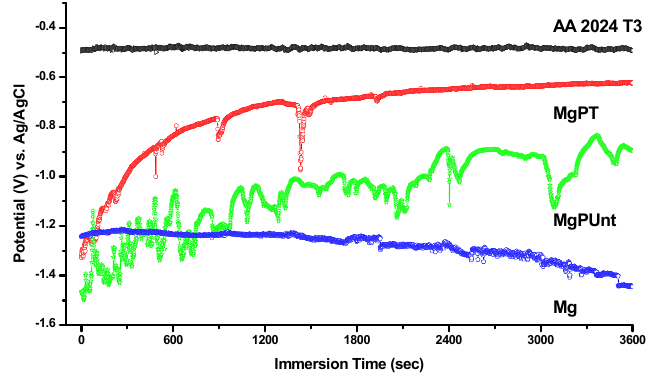
Figure 5. Open circuit potential (OCP) values of Mg cube, bare AA2024 T3, MgPUnt and MgPT monitored for an hour in a 3.5 wt% NaCl